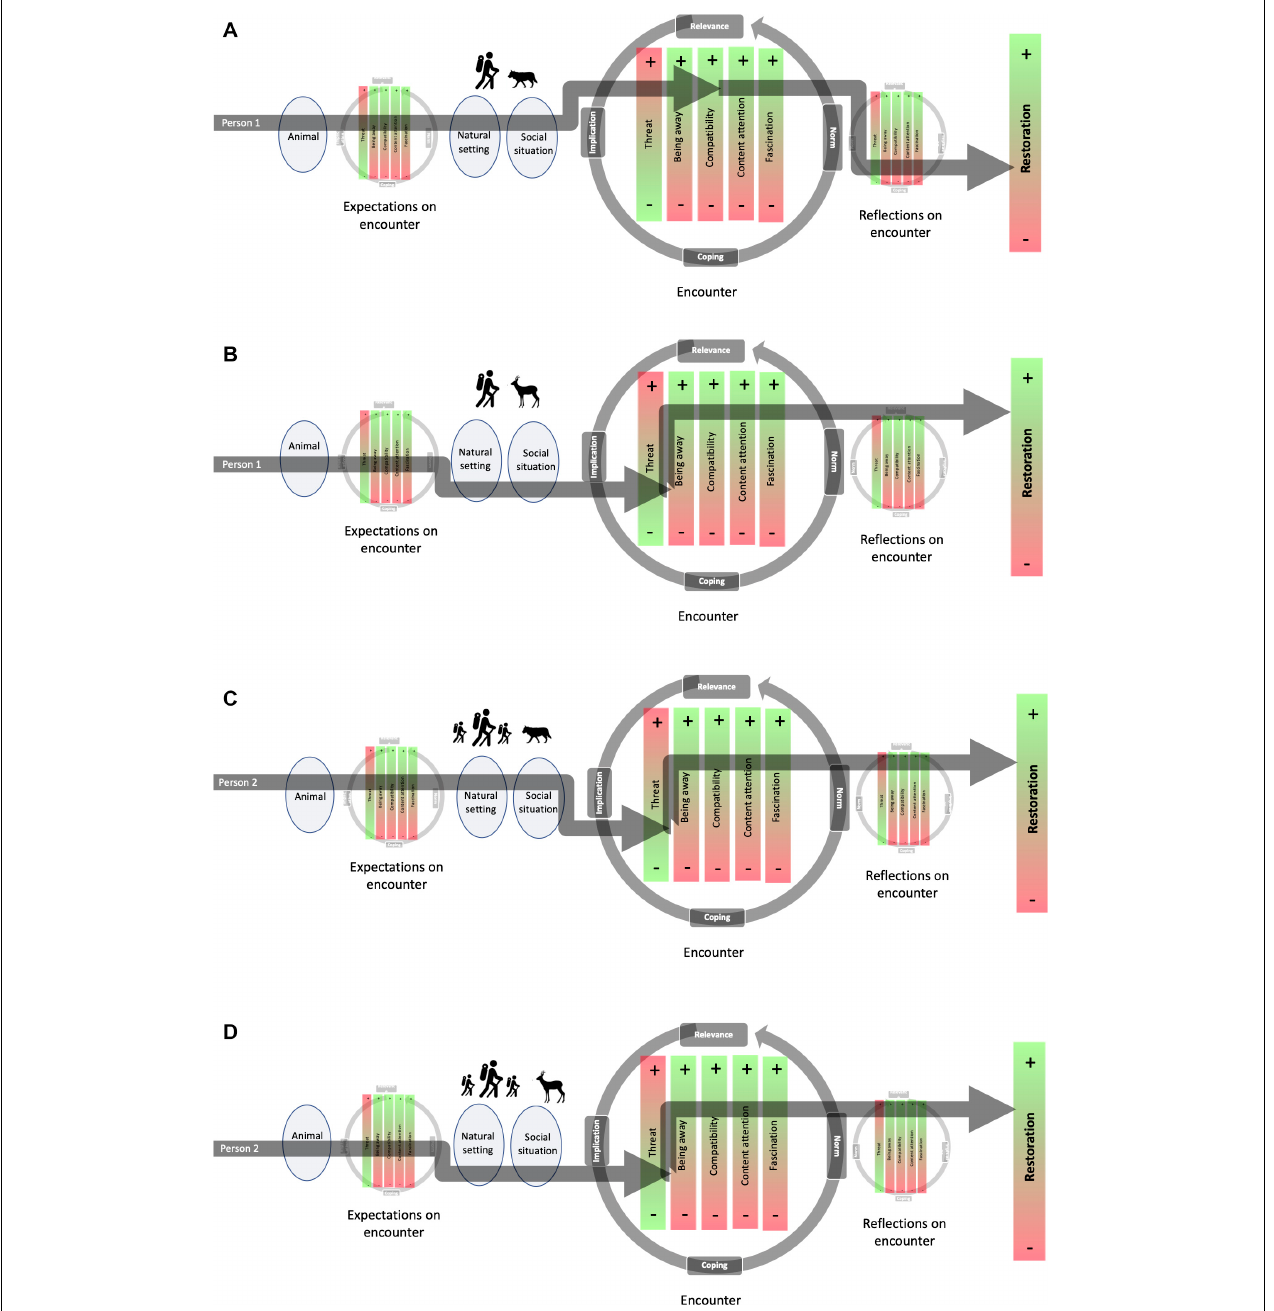
FIGURE 3 | Descriptions of how different factors might influence the restorative effect of an encounter with wildlife during a visit to a natural setting. (A) An older woman encountering a wolf she feels unable to cope with experiences threat that undermines the restorative process. (B) An older woman encountering an unthreatening roe deer enhances the restorative process. (C) On encountering a roe deer, a middle-aged man appreciates the way his two small children engage with the animal, and this enhances the restorative process. (D) A middle-aged man does not appraise a wolf as a threat, and the rare encounter enhances his restorative